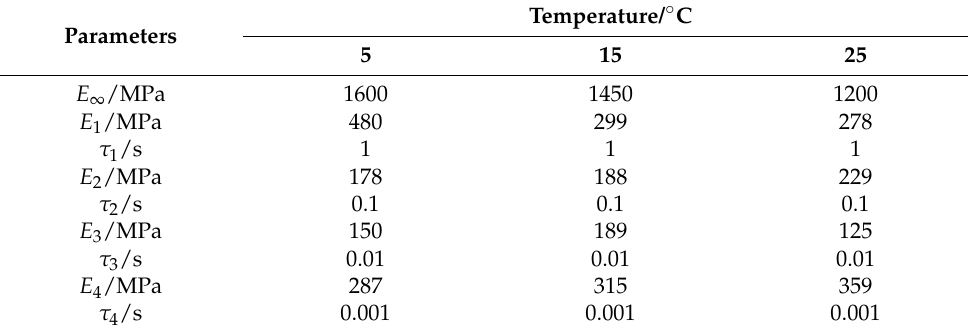
Figure 1. Generalized Maxwell model. Table 1. Generalized Maxwell model parameters ( n = 4).